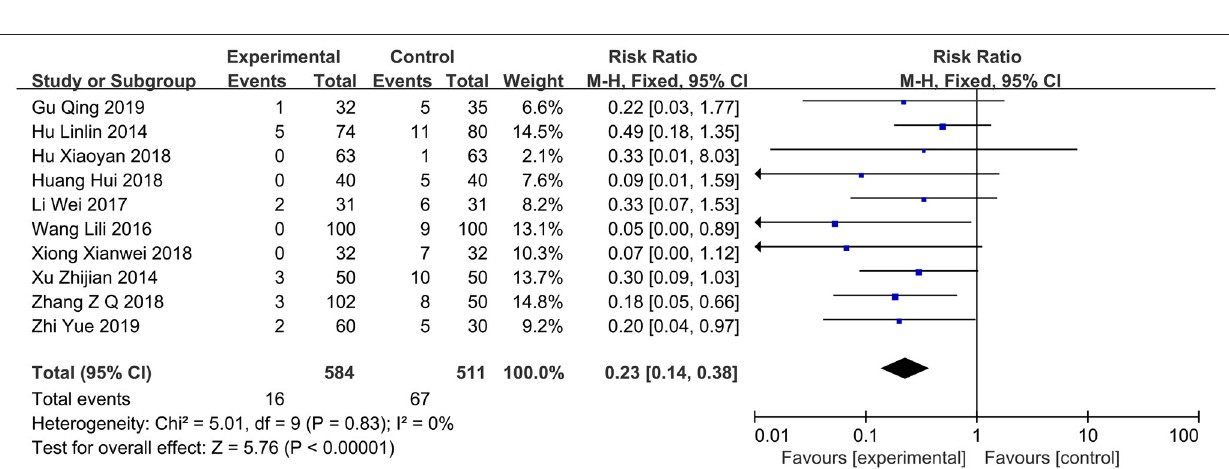
FIGURE 4 | Forest plot of the clinical efficacy between the PPI treatment group and the conventional treatment group. PPI, proton-pump inhibitor.